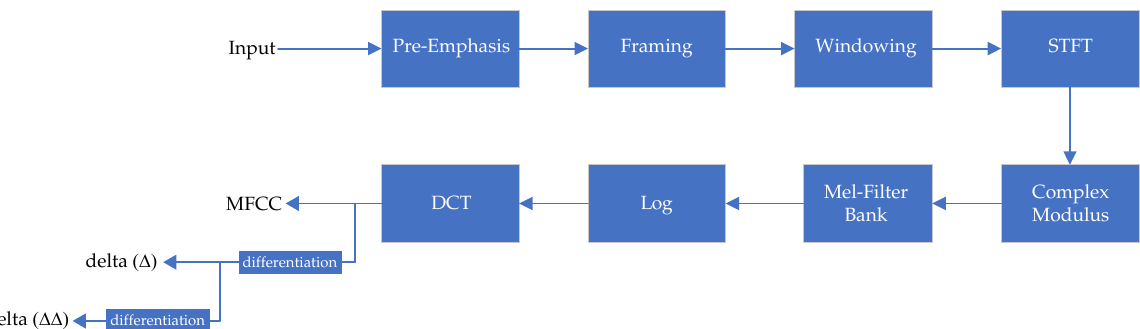
Figure 3. Block diagram of the MFCC process and its derivatives.